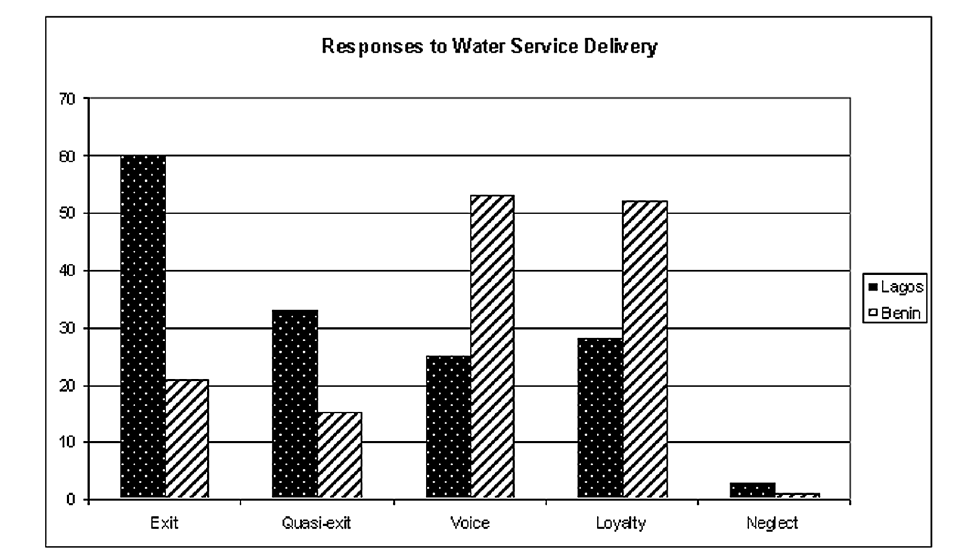
Finding 2: Household Response to Dissatisfaction with Water